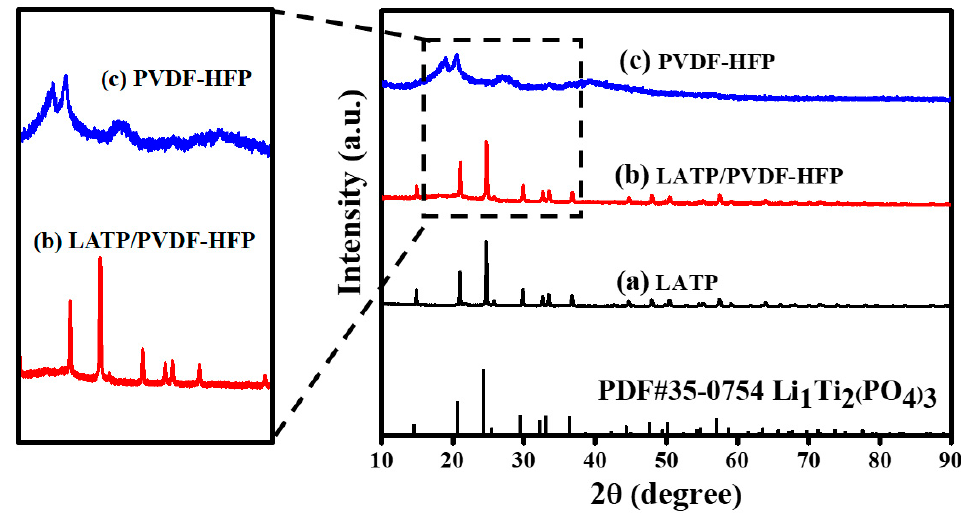
Figure 1. X-ray diffraction (XRD) patterns of ( a ) Li 1.3 Al 0.3 Ti 1.7 (PO 4 ) 3 powder, ( b ) LATP/PVDF-HFP Figure 1. X-ray di ff raction (XRD) pa tt erns of ( a ) Li 1.3 Al 0.3 Ti 1.7 (PO 4 ) 3 powder, ( b ) LATP/PVDF-HFP composite electrolyte membrane, and ( c ) pure composite electrolyte membrane, and ( c ) pure PVDF-HFP.